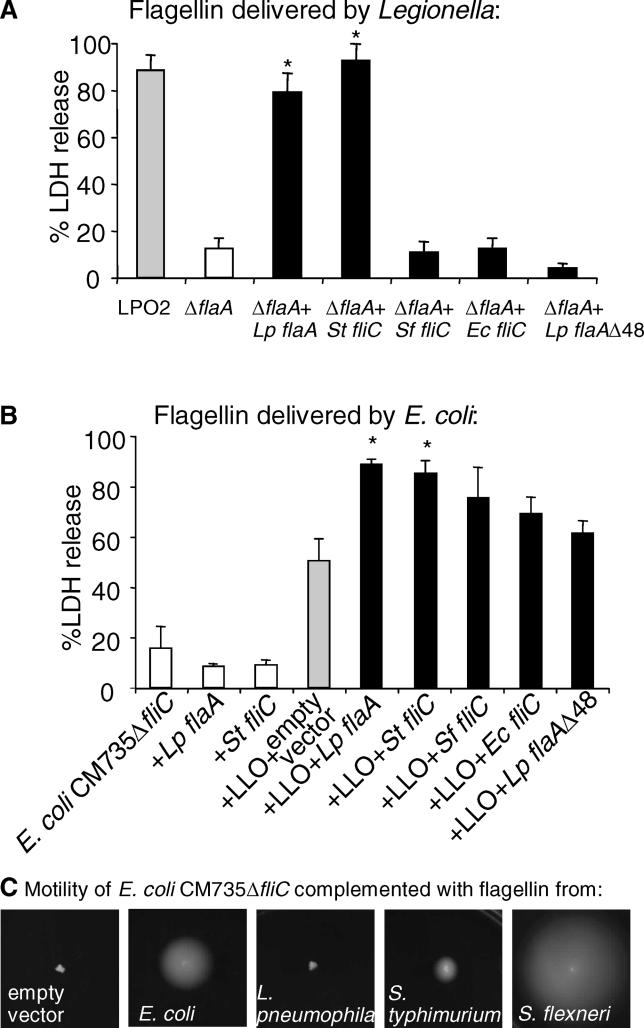

Salmonella and Legionella Flagellin Induce Macrophage Death(A) Salmonella flagellin complements a ΔflaA mutant of Legionella. The LP02 ΔflaA mutant was complemented with plasmids expressing flagellin of L. pneumophila (Lp flaA), S. typhimurium (St fliC), S. flexneri (Sf fliC), or E. coli (Ec fliC). A 48-amino acid C-terminal truncation mutant of FlaA (Lp flaAΔ48) was also expressed as a control. Infection and LDH release of B6 macrophages were assayed as in Figure 3. An MOI of 2 was used in this experiment. Asterisks denote p < 0.02 (two-tailed student's t-test) versus ΔflaA + Lp flaAΔ48.
(B) Flagellin from Legionella and Salmonella induce macrophage death when delivered to the cytosol by E. coli. A flagellin-deficient strain of E. coli (CM735ΔfliC) was transformed with the same plasmids as in (A), or an empty vector as a control. In some cases, the E. coli also expressed a non-secreted form of the pore-forming toxin LLO. In this system, E. coli is degraded in the phagolysosome, releasing cytoplasmic LLO. LLO forms pores in the phagosome, giving phagosomal contents access to the cytosol. Infection and LDH release of B6 macrophages was assayed as in Figure 3. An MOI of 2 was used in this experiment. Asterisks denote p < 0.02 (two-tailed student's t-test) versus LLO + empty vector (gray bar). The p-value for LLO + Sf fliC was 0.05; the p-value for LLO + Ec fliC was 0.05; and the p-value for LLO + Lp FlaAΔ48 was 0.155.(C) The E. coli CM735ΔfliC-derived strains from (B) were tested for the ability to swim through soft agar (motility) plates. Nonmotile strains remain at the point of inoculation, whereas motile strains show a halo of bacteria swimming outward from the point of inoculation.